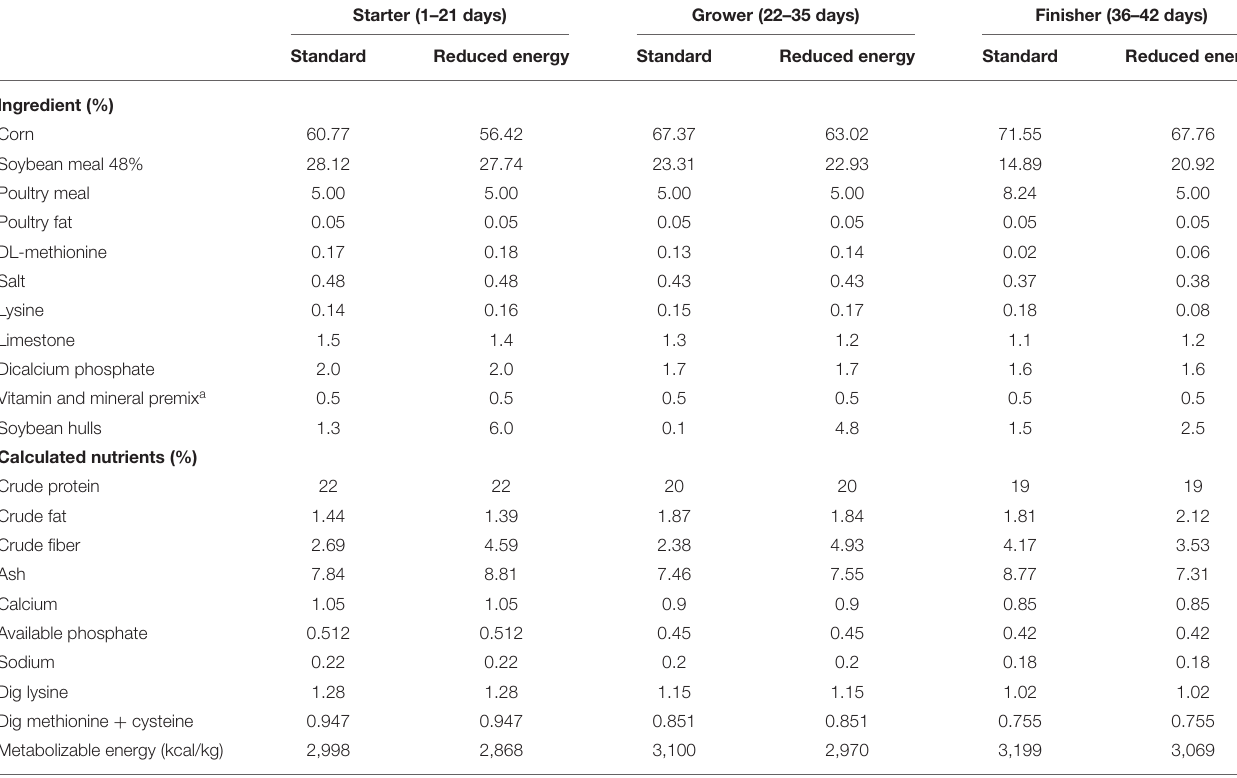
TABLE 1 | Composition and nutrient content of experimental diets.